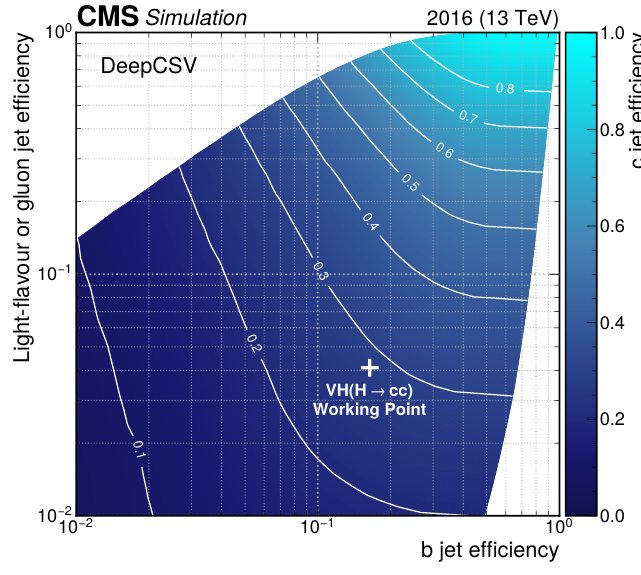
Figure 1 . E(cid:14)ciency to tag a c jet as a function of the b jet and light-(cid:13)avour quark or gluon jet mistag rates. The working point adopted in the resolved-jet topology analysis to select the leading CvsL jets is shown with a white cross. The white lines correspond to c jet iso-e(cid:14)ciency curves. The plot makes use of jets with p > 20 GeV that have been clustered with AK4 algorithm in a T simulated tt+jets sample before application of data-to-simulation reshaping scale